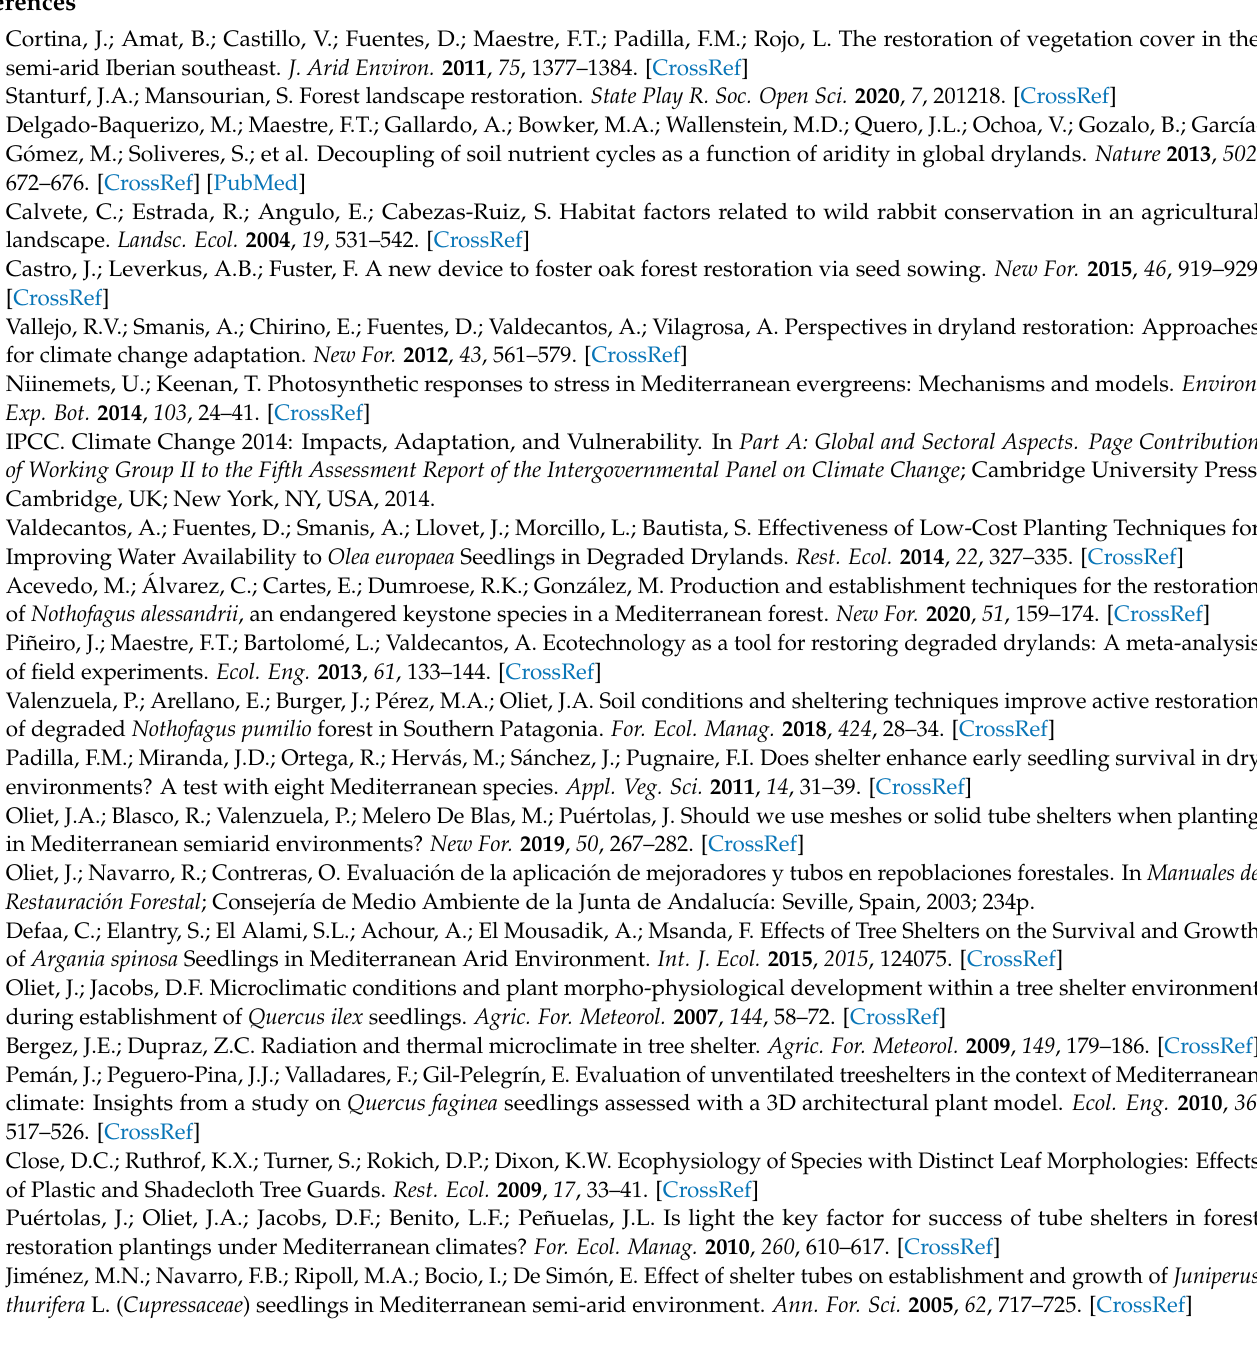
Figure A2. Tree shelters of four light transmissivities (from 20 to 80%) tested in the experiment .